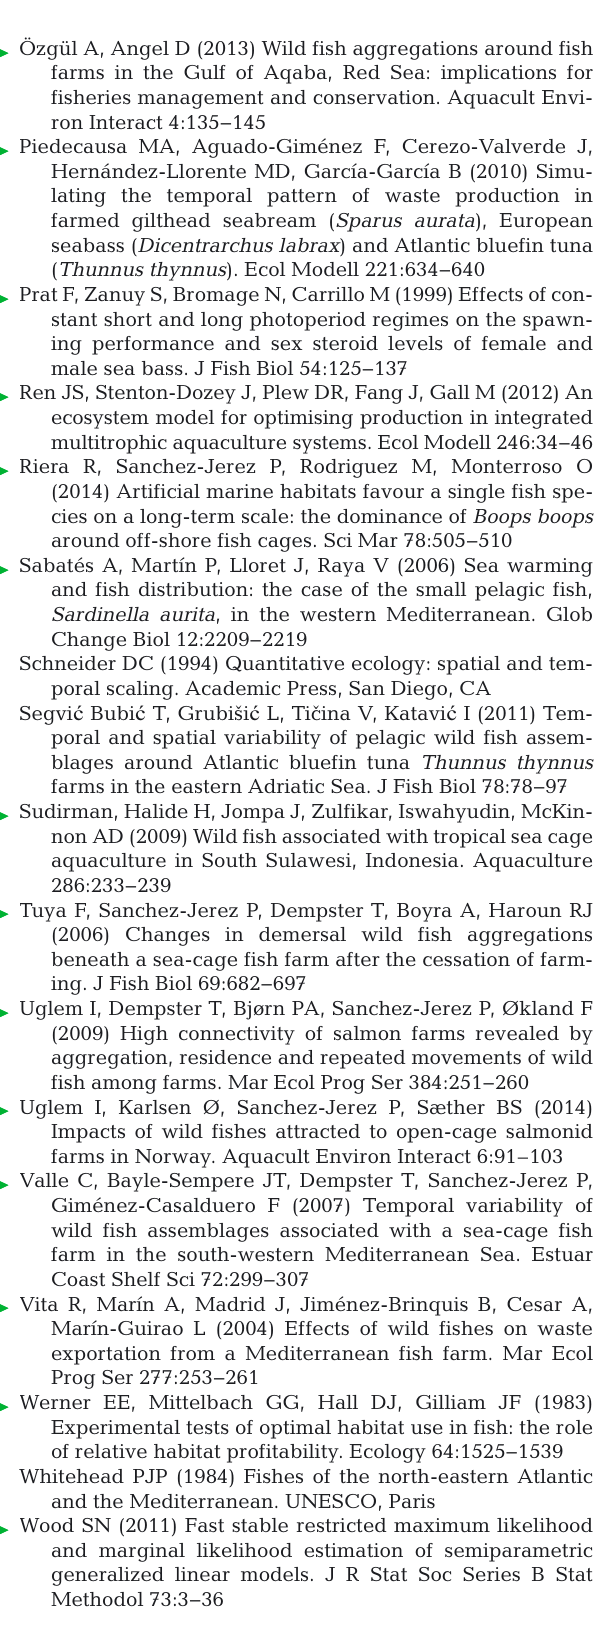
Whitehead PJP (1984) Fishes of the north-eastern Atlantic and the Mediterranean. UNESCO, Paris Wood SN (2011) Fast stable restricted maximum likelihood and marginal likelihood estimation of semiparametric generalized linear models. J R Stat Soc Series B Stat Methodol 73: